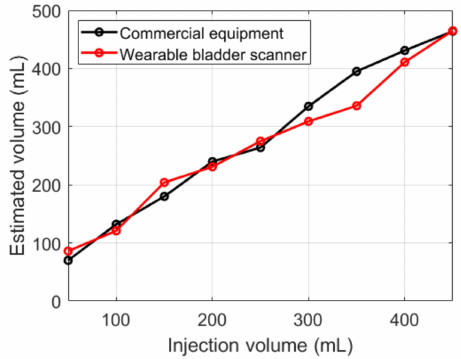
Figure 12. Estimated bladder volumes with various injection